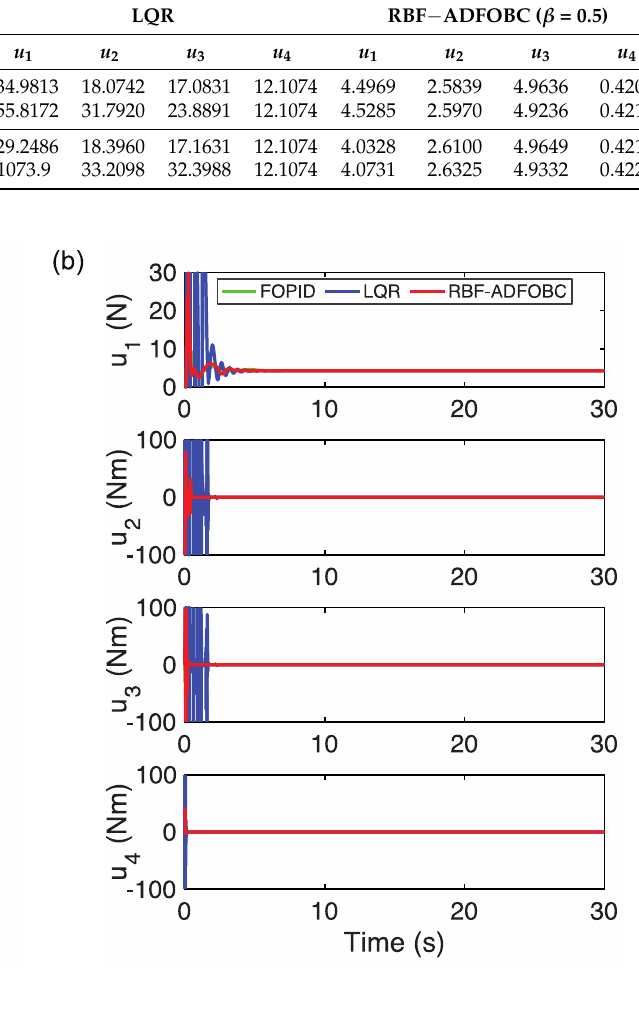
Figure 10. Comparison of the simulated control signals with three controllers ( 𝛽 = 0.5 in RBF- ADFOBC) in response to various payloads and uncertain input time delays: ( a ) 𝑑 (cid:2871) = 2 m/s 2 and 𝜏 = 0.05 s, ( b ) 𝑑 (cid:2871) = 2 m/s 2 and 𝜏 = 0.10 s, ( c ) 𝑑 (cid:2871) = 4 m/s 2 and 𝜏 = 0.05 s, ( d ) 𝑑 (cid:2871) = 4 m/s 2 and 𝜏 = 0.10 s. (Assume that 𝑑 (cid:2869) = 𝑑 (cid:2870) = 𝑑 (cid:2872) = 𝑑 (cid:2873) = 𝑑 (cid:2874) = 0 and 𝜏 = 𝜏 (cid:2869) = 𝜏 (cid:2870) = 𝜏 (cid:2871) = 𝜏 (cid:2872) .) Table 20. Comparison of the root mean squared value of the control signals in the three controllers under different payloads, different input time delays and different fractional orders. Payloads (m/s 2 ) 𝝉 (s)